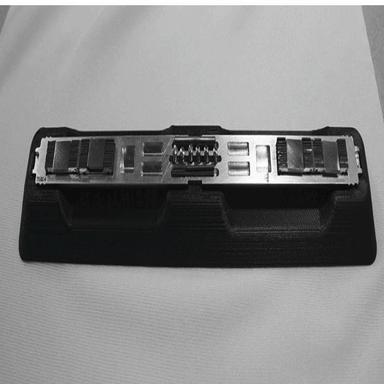
Photograph of the TTUSC experiment fixture loading.